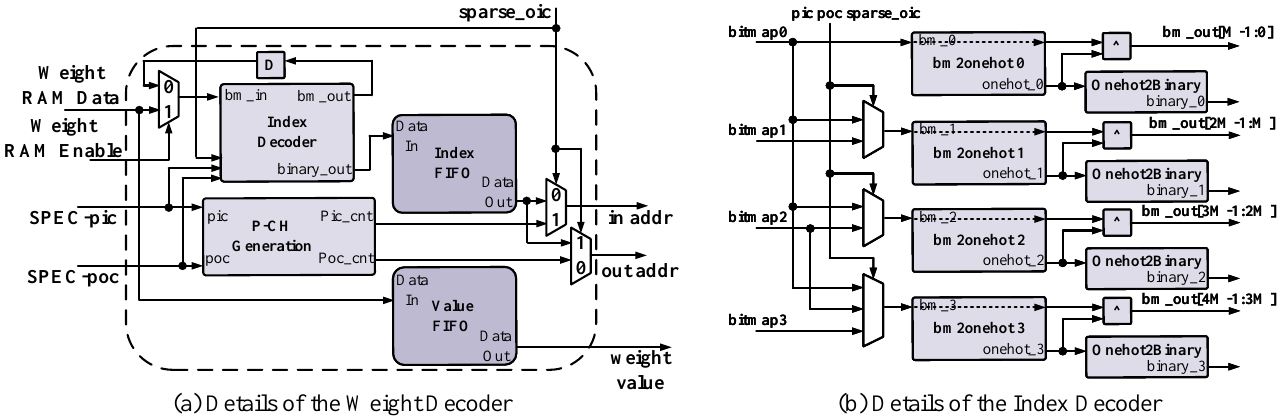
Figure 7. Details of the Weight Decoder. The ‘D’ in a box denotes the register used for